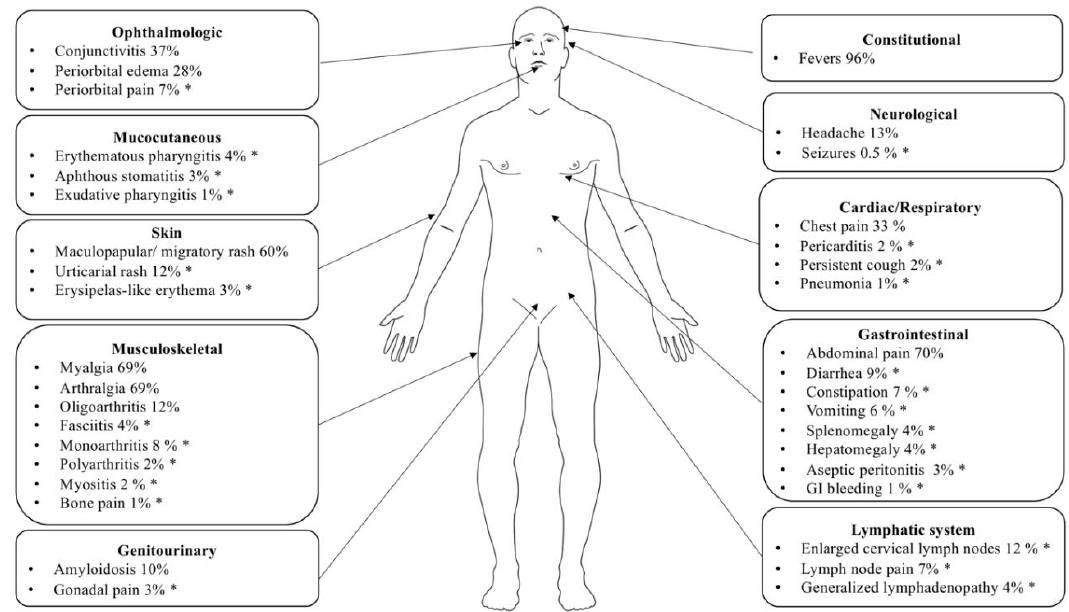
Figure 3. Summary of most common clinical manifestations in TRAPS. Organ-specific clinical manifestation of 209 TRAPS patients with variants validated as pathogenic and likely pathogenic in the Infevers database. * Not all reports contained an explicit description of these symptoms and they may be present in a larger proportion of patients than reported here